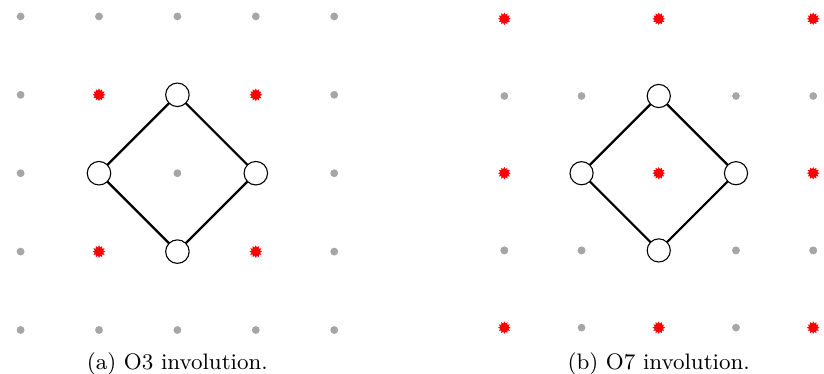
Figure 3. Two choices of even sublattices for Z 2 . As explained in [19], these correspond to the two choices of toric involutions of C C ( F 0 ) with compact orientifold locus, up to equivalences. We have named the two involutions according to the kind of orientifold planes that arise when blowing up the